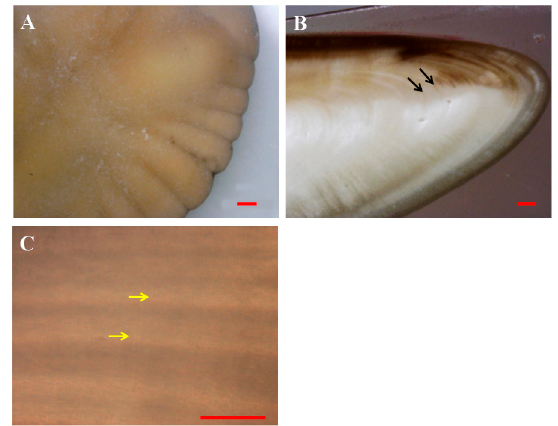
Figure 6. Micrograph of Coryphaenoides cinereus (Gilbert). The narrower incremental lines were unclear. The long-period incremental lines (yellow arrows: average 33 µ m, and black arrows: average 97 µ m) were observed. Digital microscopy images ( A : otolith surface, B : cross-sectional image). Ground specimen of polarizing micrograph ( C ). Scale bar: 500 µ m ( A ), 100 µ m ( B ), 50 µ m ( C ).